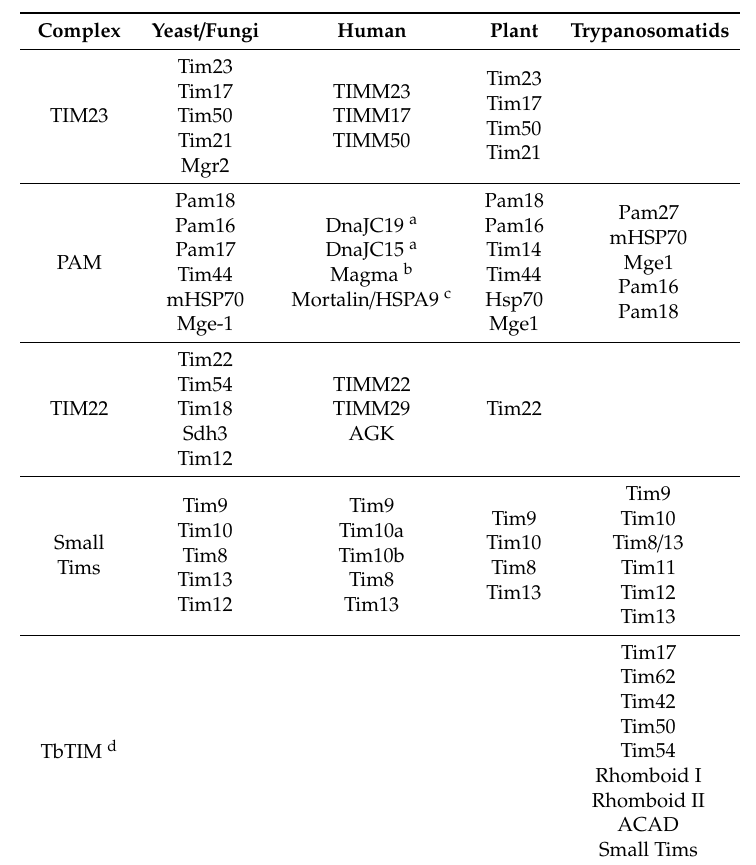
Table 2. Components of the TIM complexes in di ff erent